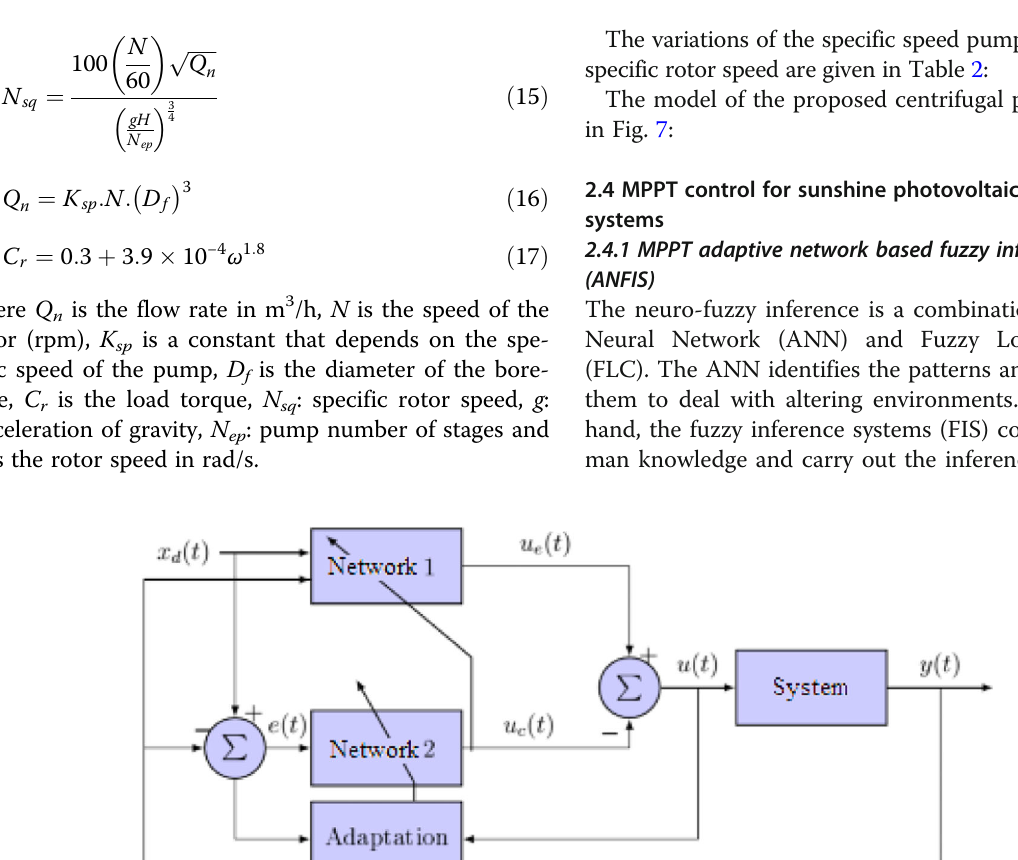
Fig. 12 Inputs and Outputs of ANFIS after Training